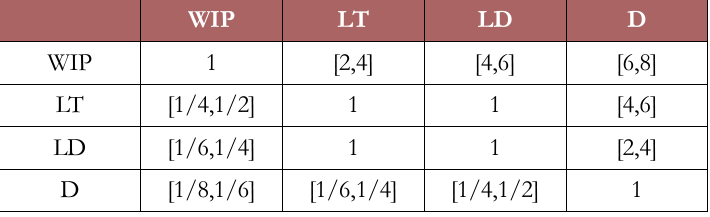
Table 5. α-Cuts fuzzy comparison matrix for the criteria (α = 0.5, μ =